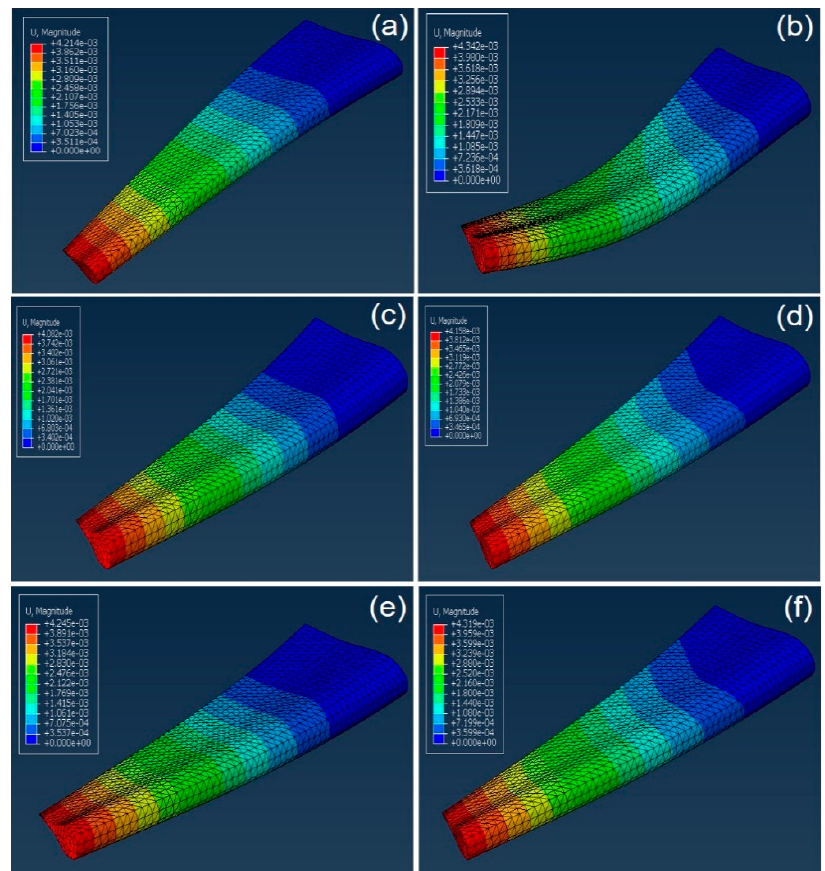
Figure 10. First two modes of wing natural frequency of ( a ) ZrB 2 –SiC–TaC for the leading edge (model I), ( b ) ZrB 2 –SiC–TaC for the leading edge (model II), ( c ) ZrB 2 –SiC–TaC for the body of